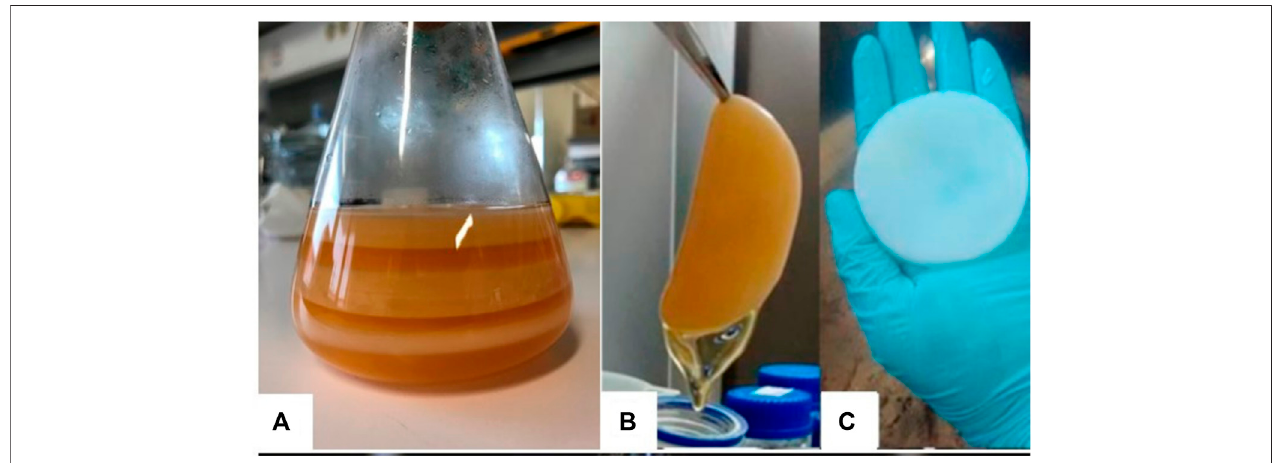
FIGURE 1 | BNC shapes: BNC membranes produced in static fed-batch conditions (A) ; wet BNC membrane produced in static culture in Hestrin-Schramm (HS) medium, before puri fi cation (B) and after puri fi cation (C) . Reprinted with permission from Almeida et al. (2014) under Creative Commons Attribution License (CC